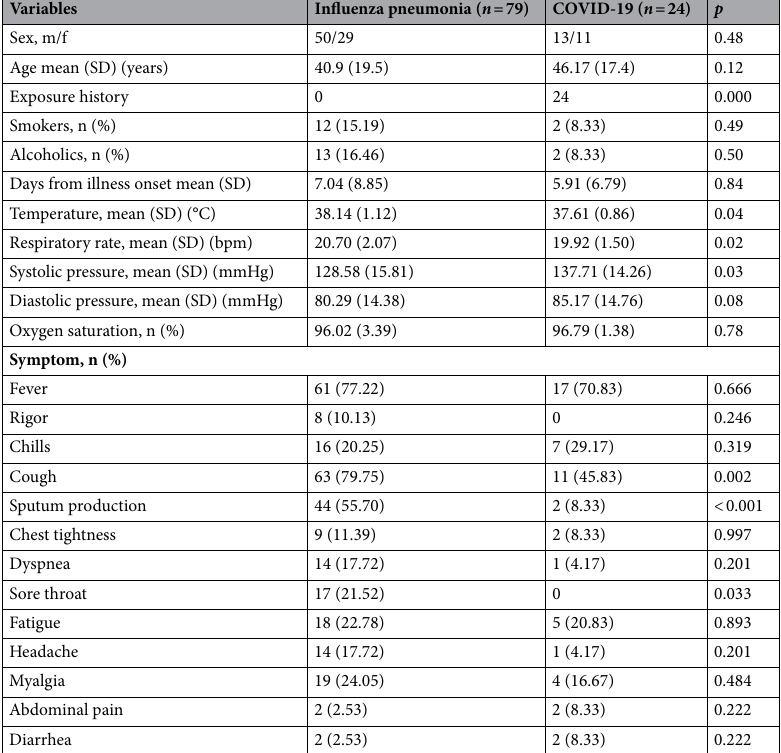
Table 1. The clinical variables in 79 patients with influenza pneumonia and 24 with COVID-19. Data are expressed as mean ± standard deviation or number of cases